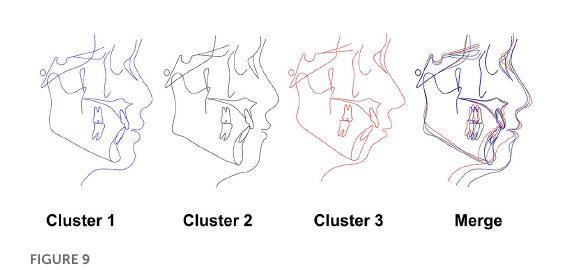
FIGURE9 Characteristics of each cluster. The cephalometric image of the 3 subgroups as described in the